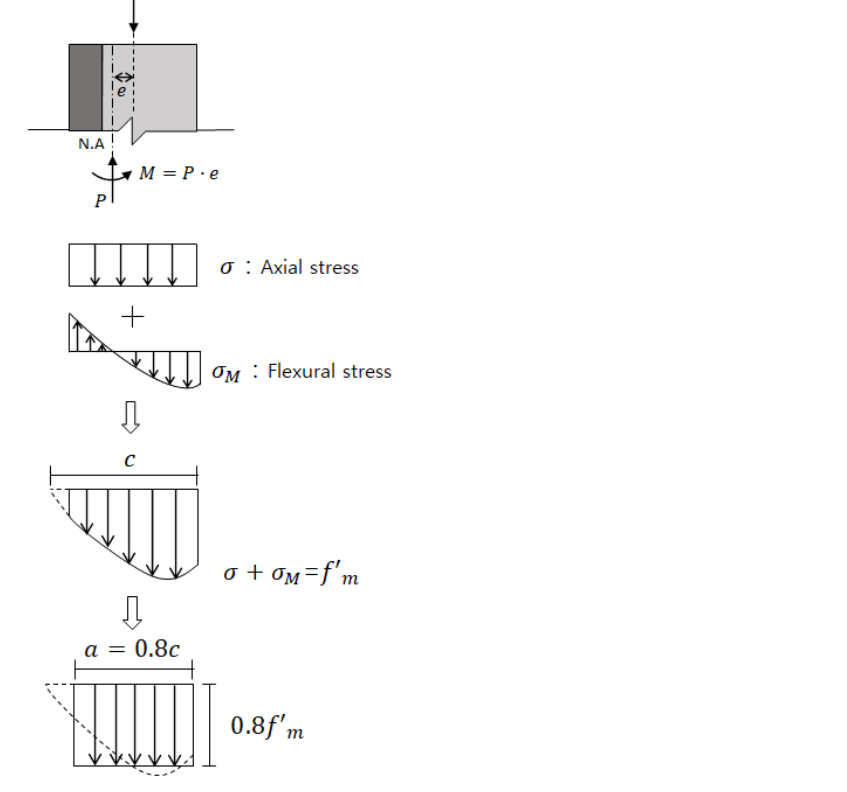
Figure 14. Detailed transformed section for calculating equivalent stress block.